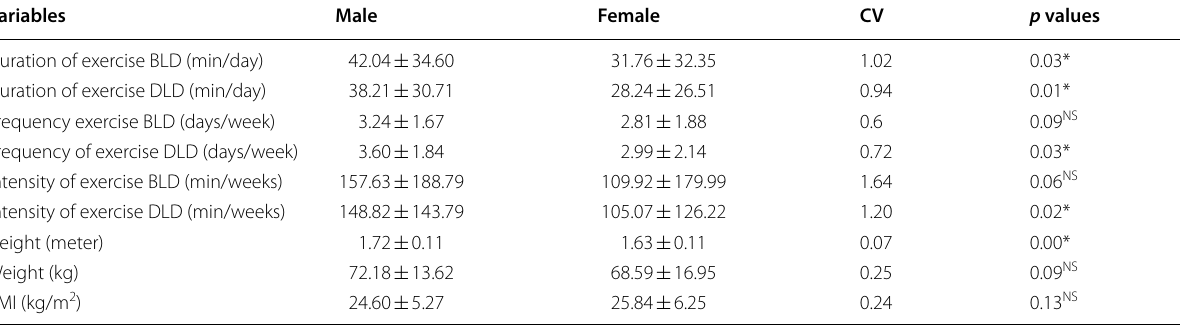
BLD, before the lockdown; DLD, during the lockdown; CV, coefficient of variation * p < 0.05 significant; NS, not significant, value are mean